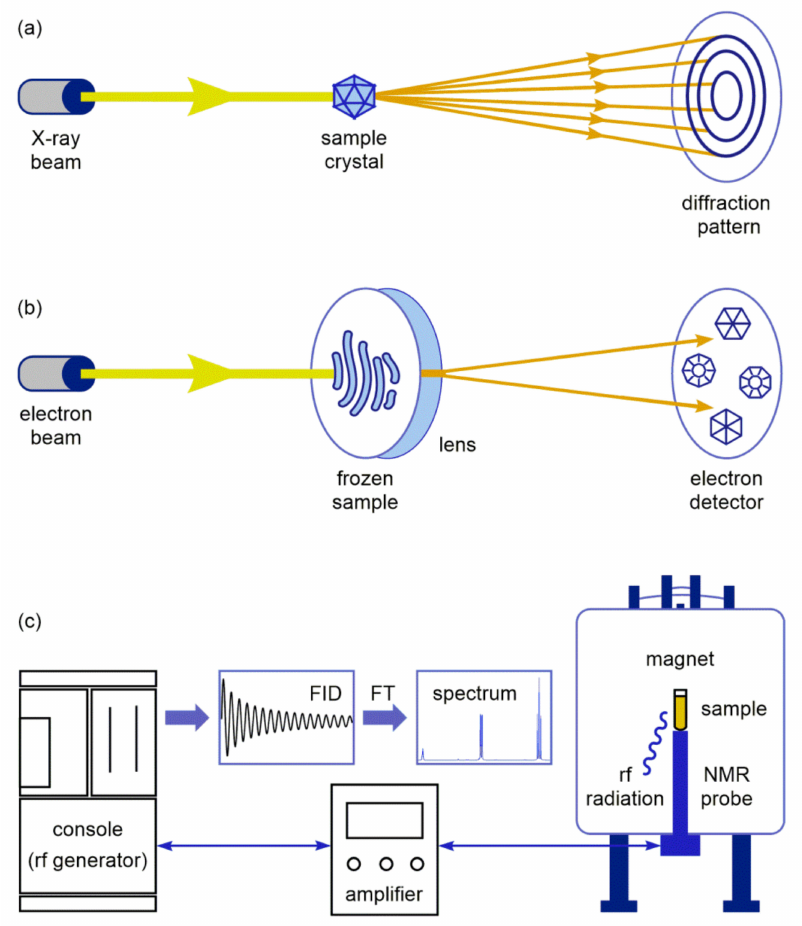
Figure 2. Basic principles of: ( a ) X-ray crystallography; ( b ) Cryogenic electron microscopy (Cryo-EM); ( c ) NMR